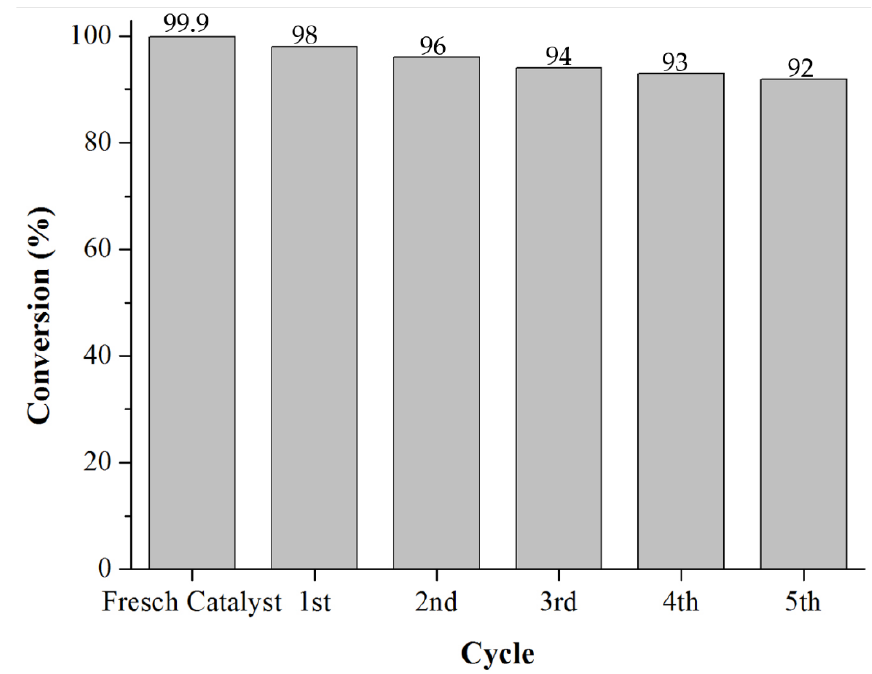
Figure 11. Reaction conditions: eugenol: acetic anhydride (1:5), reaction temperature 80 °C, reaction time 40 min and 2% catalyst.